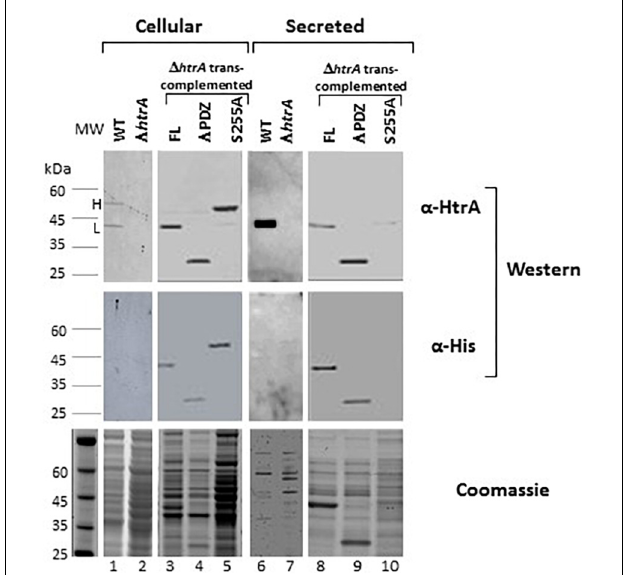
FIGURE 2 | The S255A mutation abrogating the proteolytic activity prevents the N terminus auto-processing and secretion of HtrA BA . Western-blot analysis of cellular (lanes 1–5) and secreted (lanes 6–10) proteins of the WT parental (cid:49) Vstrain (lanes 1 and 6), (cid:49) V (cid:49) htrA (lanes 2 and 7) and the trans -complemented strains (cid:49) V (cid:49) htrA/HtrA (lanes 3 and 8), (cid:49) V (cid:49) htrA/HtrA (cid:49) PDZ (lanes 4 and 9) and (cid:49) V (cid:49) htrA/HtrA S255A (lanes 5 and 10). Western blots were probed with anti-HtrA and anti-His antibodies, as indicated. The two forms of HtrA BA are indicated as H (heavy, unprocessed) and light